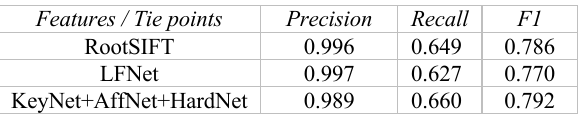
Table 6: Precision (accuracy), recall (completeness) and F1 scores for tolerance τ = 0.5